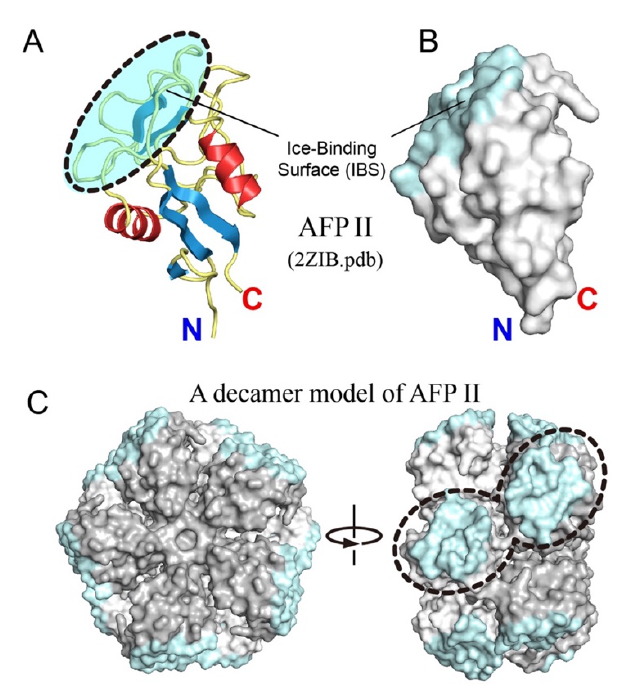
Figure 5. Prediction of a decamer model of AFP II. ( A ) A ribbon representation of the crystal structure of AFP II (2ZIB.pdb) whose α -helices, β sheets, and loops are shown in red, blue, and yellow, respectively. A cyan region shows the putative ice-binding site (IBS) contributed by I58, C86, K89, N91, I93, S95, M99, Q100, T102–D106, C108, D110–H118. ( B ) Surface representation of AFP II whose orientation is the same as ( A ). ( C ) A structural model of AFP II created by using a decamer structure of rattlesnake venom lectin (RSL) (1JZN.pdb) as a template. A front view of the model (left) shows that the IBSs are located at the rim of the decamer disk. The side view (right) shows that two imperfectly aligned IBSs are proximal to each other.